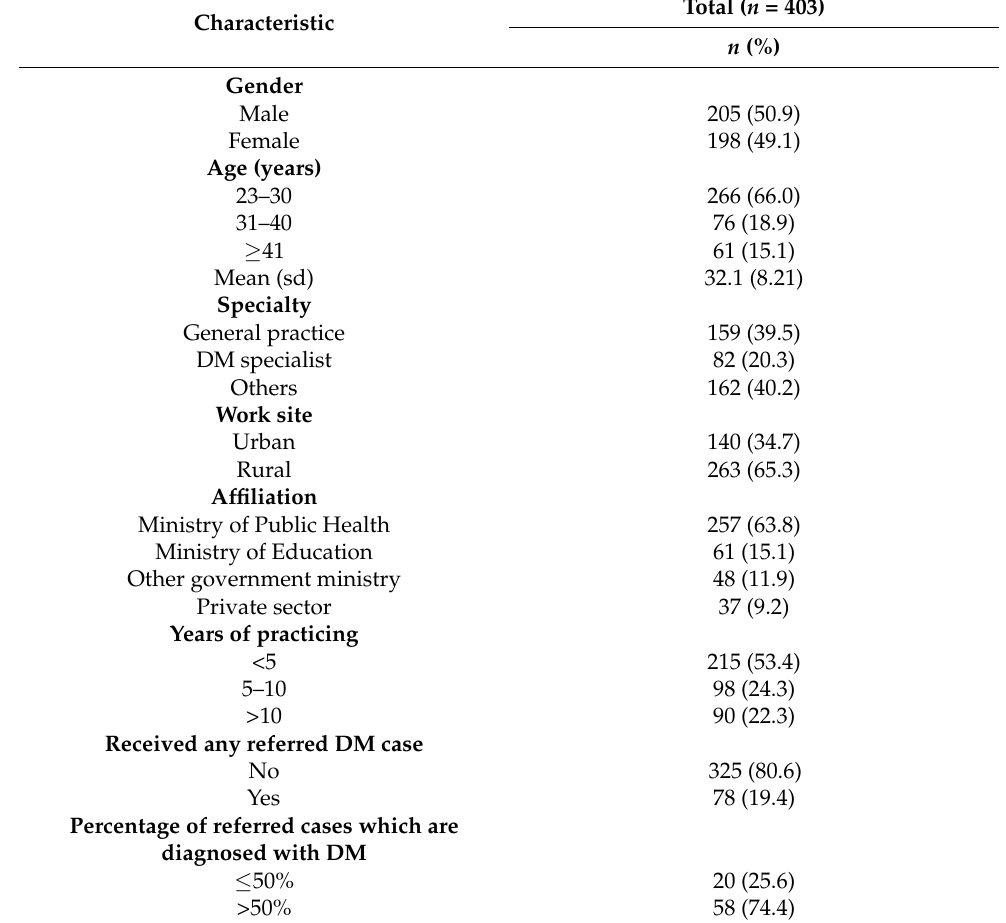
Table 1. General characteristics of participants and referral system.